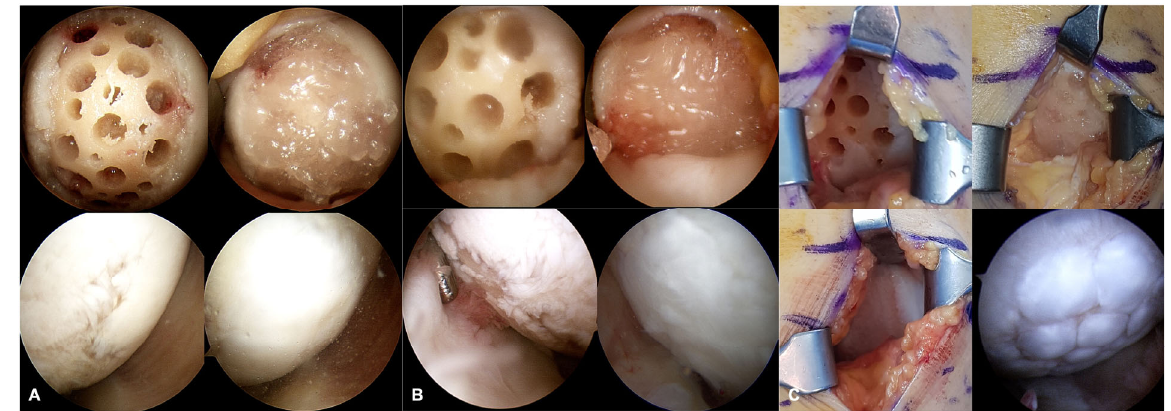
Figure 4. Evaluation of the repaired cartilage according to the ICRS Macroscopic Assessment of Cartilage Repair during second look arthroscopy. ( A ) A case of ICRS cartilage repair assessment score of 12, which was grade I in overall repair assessment, i.e., “normal”. ( B ) A case of ICRS cartilage repair assessment score of 9, which was grade II in overall repair assessment, i.e., “nearly normal”. ( C ) A case of ICRS cartilage repair assessment score of 5, which was grade II in overall repair assessment, i.e., “abnormal”.